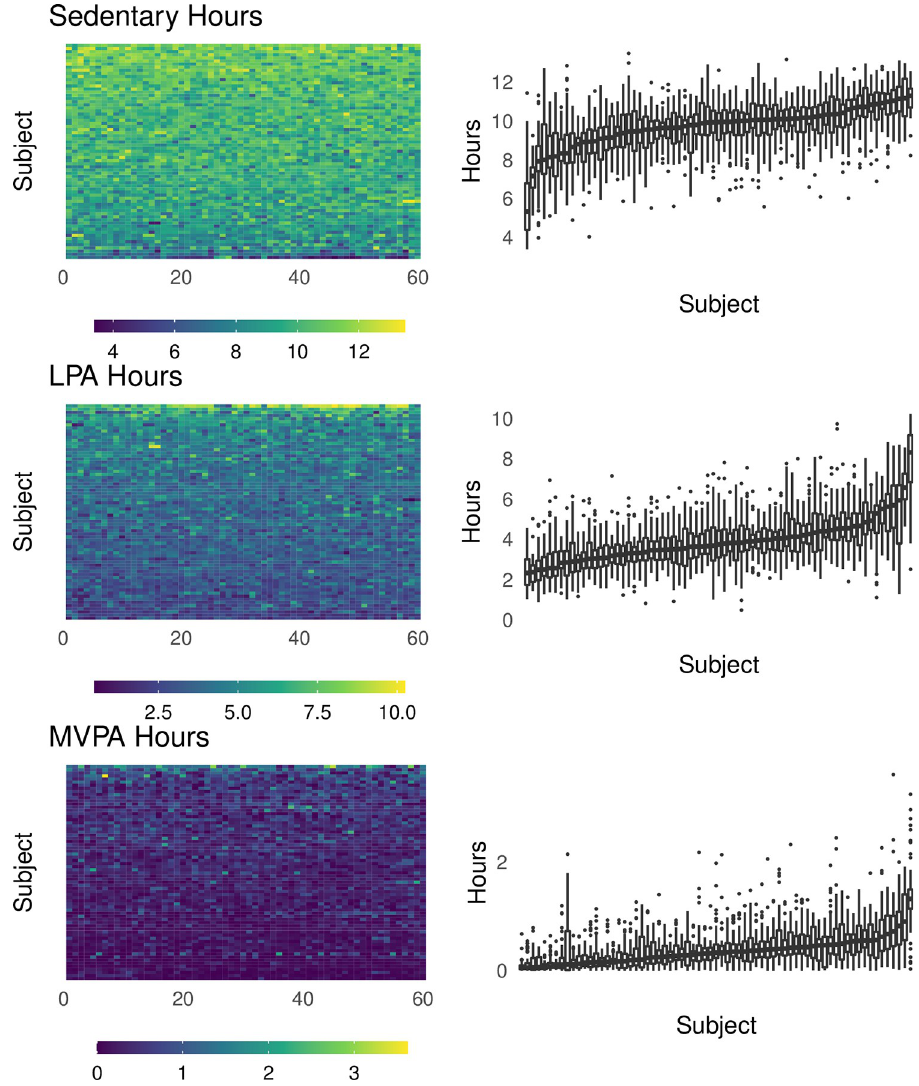
Fig 2. Activity metric distributions in the motivating data set. The left column of panels shows the heatmaps for each metric and participant over the 60 days of observation included in the present analysis. The right column shows boxplots of sedentary, light, and MVPA time for each participant over the course of the study, sorted based on the median value for each metric separately. Individual boxes show bars at the median value, hinges at the 25% and 75% quantile, and whiskers extending to observed values within (hinge ± 1.5 � IQR). Data points outside the range of whiskers are